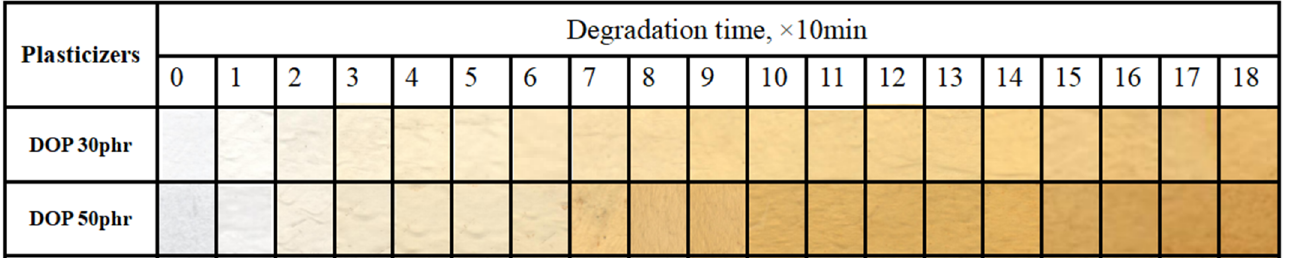
Figure 1. The influence of DOP content on the thermal stability of PVC at 180 °C in air.